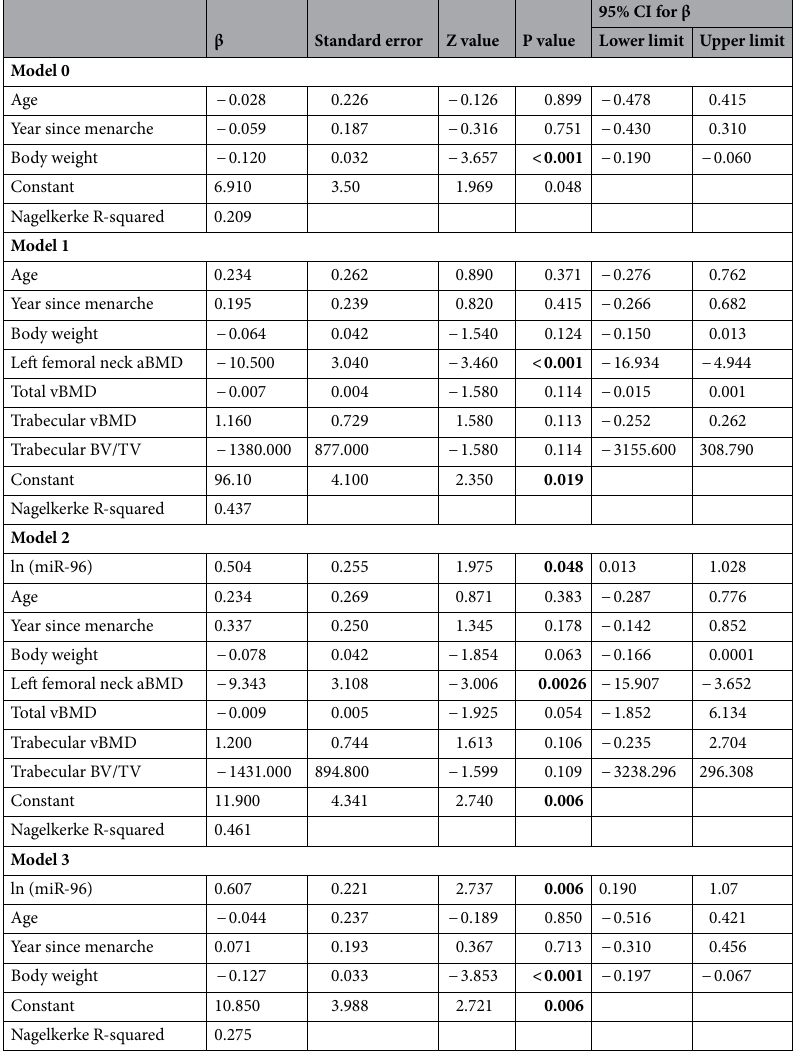
Table 3. Logistic regression models to predict AIS. Plasma level of miR-96-5p with log transformation, maximum Cobb angle at first visit, maturity (age, years since menarche), anthropometry (body weight,